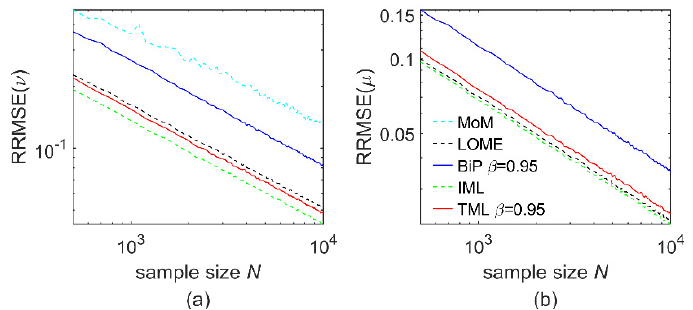
Figure 3. Performance comparison of the five estimators for data without outliers: ( a ) RRMSEs of the inverse shape parameter; ( b ) RRMSEs of the scale parameter.